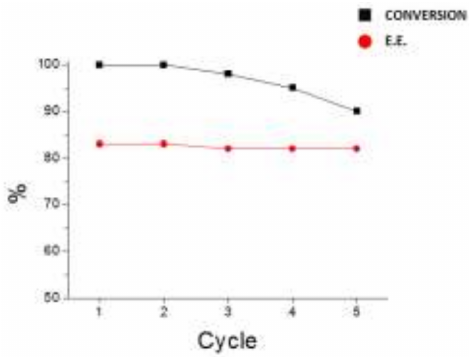
Figure 2. Enantiomeric excess (E.E.) variations and conversion values measured after 3 h by recycling 1-Mn in the epoxidation of 1,2-dihydronaphthalene. Reaction conditions are reported in Entry 9